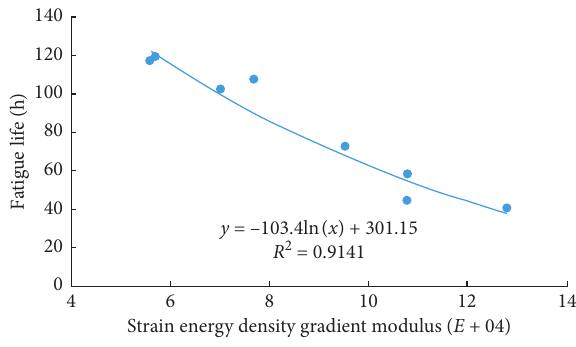
Figure 9: The fitting curves of tire fatigue life. Table 2: Failure location and crack angle